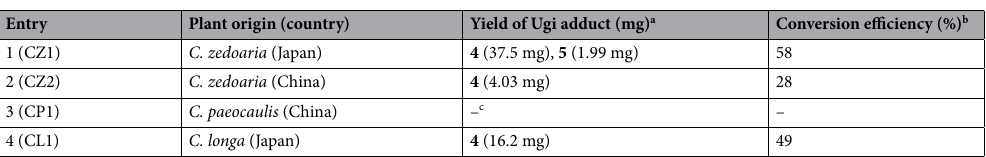
Table 1. Ugi-4CR using the extracts of the genus Curcuma . a Isolated yield. b Estimated from the curcumenone content of the extract. c Not